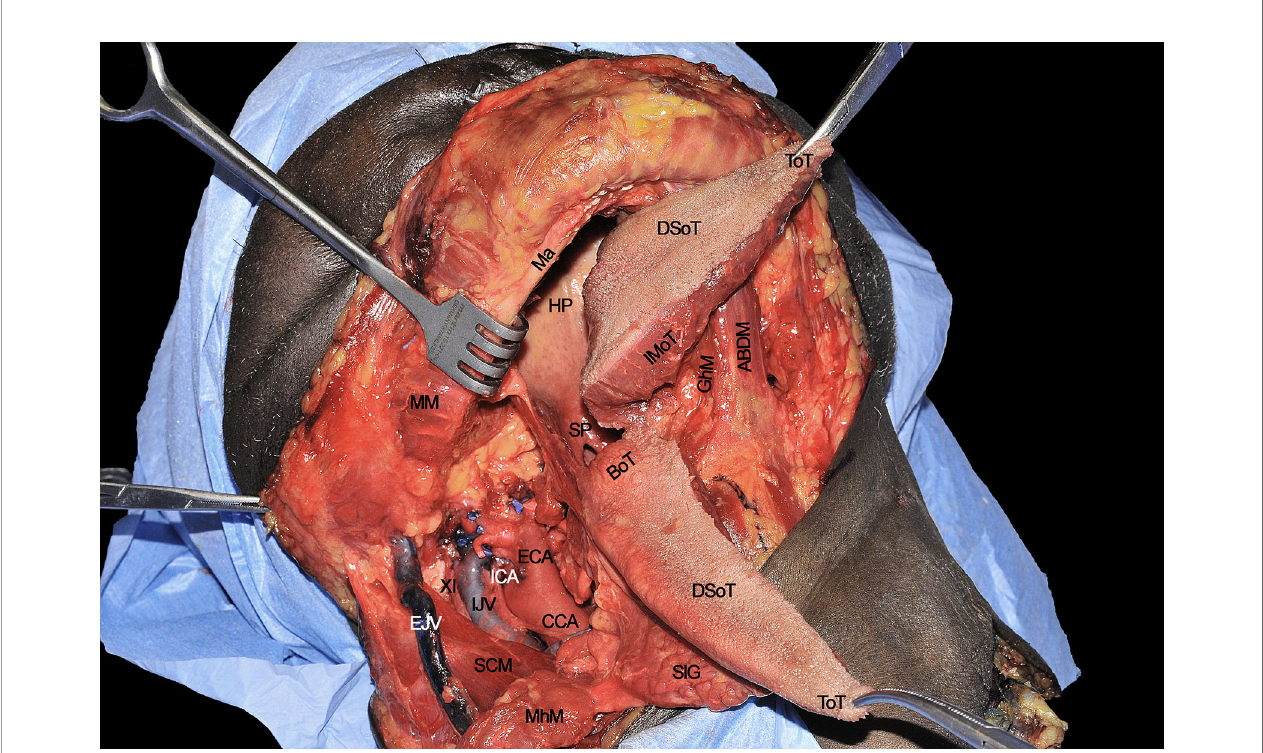
FIGURE 11 | ABDM, anterior belly of digastric muscle; BoT, base of tongue; CCA, common carotid artery; DSoT, dorsal surface of tongue; ECA; external carotid artery; EJV, external jugular vein; IJV, internal jugular vein; GhM, geniohyoid muscle; HP, hard palate; ICA, internal carotid artery; IMoT, intrinsic muscle of tongue; Ma, mandible; MhM, mylohyoid muscle; MM, masseter muscle; SCM, sternocleidomastoid muscle; SlG, sublingual gland; SP, soft palate; ToT, tip of tongue; XI, spinal accessory